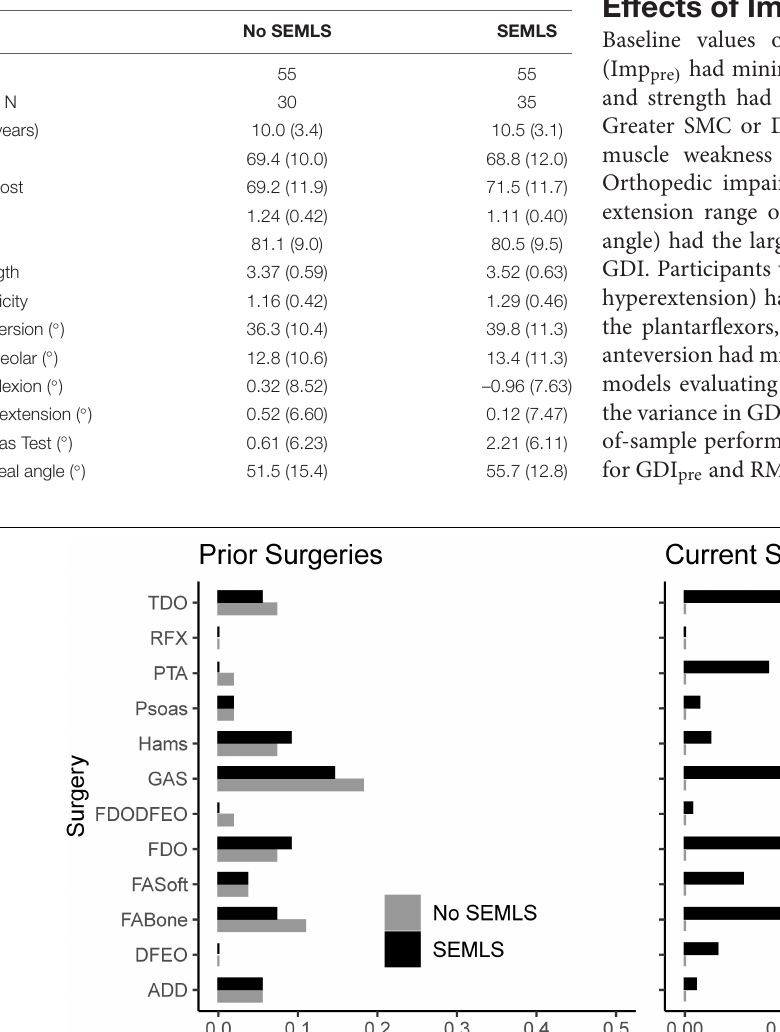
TABLE 2 | Baseline participant characteristics, average (SD).